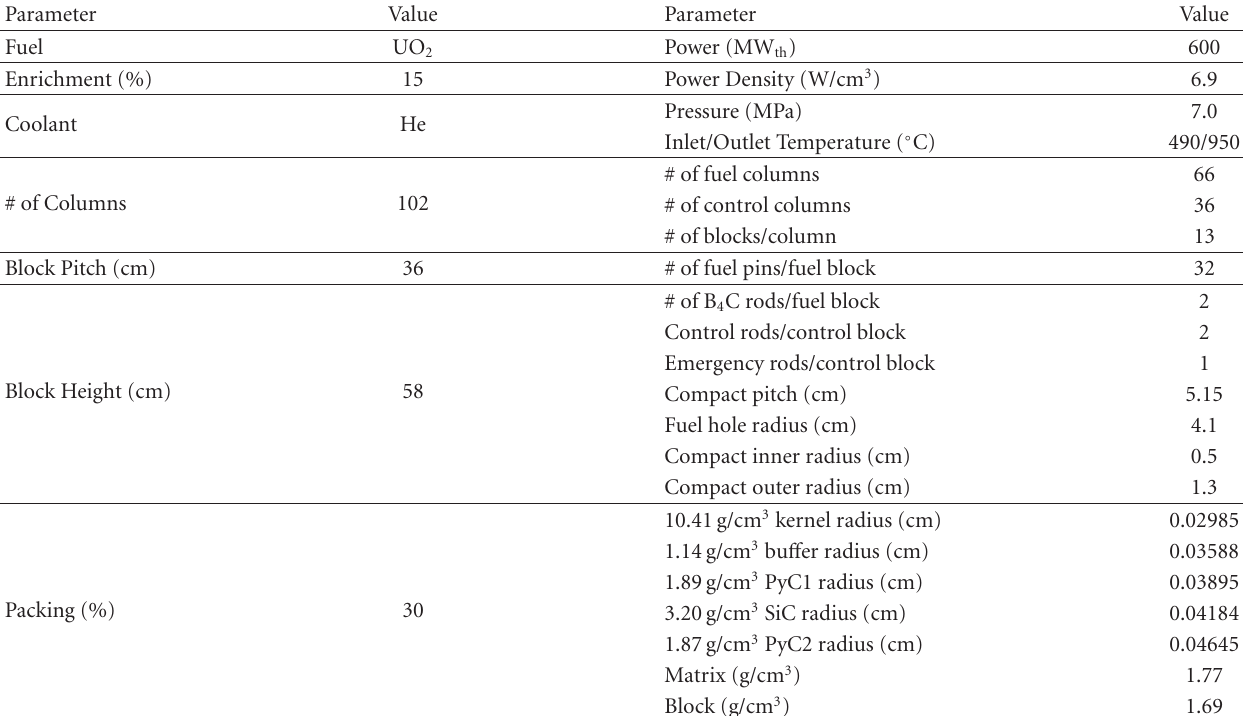
Table 1: Parameters of the Reference VHTR